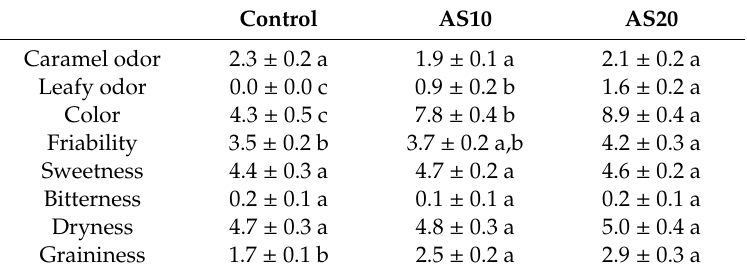
Table 7. Sensory properties of biscuits enriched by increasing levels of almond skins. Control = biscuits without almond skins; AS10 and AS20 = biscuits prepared by adding 10 g and 20 g of almond skin powder per 100 g of wheat flour,